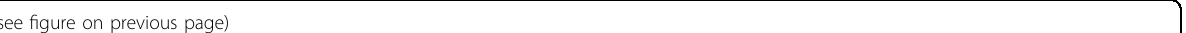
Fig. 6 The NT-induced increase in neuronal excitability is mediated by inhibiting TWIK-1/TASK-3 heterodimeric channels. a Bath application of NT-mediated membrane depolarization of granule cells. A representative response of the membrane potential to stepwise current injections was recorded from naive DGGCs ( n = 15, N = 3) or DGGCs infected with Ad-Sc shRNA ( n = 16, N = 3), Ad-TWIK-1 shRNA ( n = 17, N = 3), Ad-TASK-3 shRNA ( n = 15, N = 3), or both Ad-TWIK-shRNA and Ad-TASK-3 shRNA ( n = 14, N = 3). The resting membrane potential of these cells was maintained at − 70 mV by constant current injections, and depolarizing currents were then injected stepwise at 5-pA increments until the membrane potential reached the fi ring threshold. b , c Analyzed bar charts of spike numbers at 105 pA for a . b Resting membrane potential values of the whole-cell currents in naive dentate gyrus granule cells ( n = 15 cells, N = 3 mice) and cells expressing Sc shRNA ( n = 16 cells, N = 3 mice), TWIK-1 shRNA ( n = 17 cells, N = 3 mice), TASK-3 shRNA ( n = 15 cells, N = 3 mice), or TWIK-1/TASK-3 shRNAs ( n = 14 cells, N = 3 mice). c The extent of changes in the number of spikes following NT application in naive and Ad-Sc shRNA-infected DGGCs was larger than those in DGGCs transfected with Ad-TASK-1 shRNA alone, Ad- TWIK-1 shRNA alone, or both Ad-TWIK-1 shRNA and Ad-TASK-3 shRNAs. The data for Ad-TASK-3 shRNA alone, Ad-TWIK-1 shRNA alone, and both Ad- TWIK-1 shRNA and Ad-TASK-3 shRNAs showed no change in the numbers of spikes. The recordings were obtained in arti fi cial cerebrospinal fl